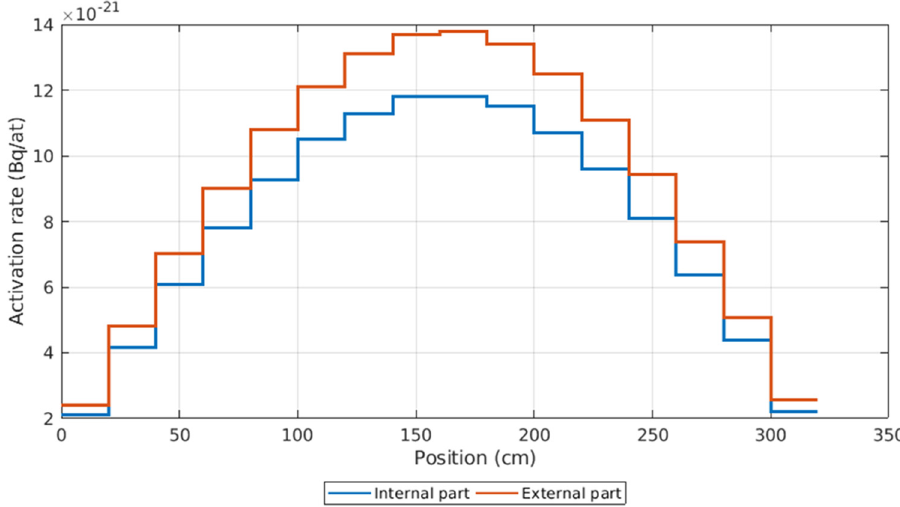
Fig. 27. Activation rate in the simpli fi ed model of the heat exchanger.